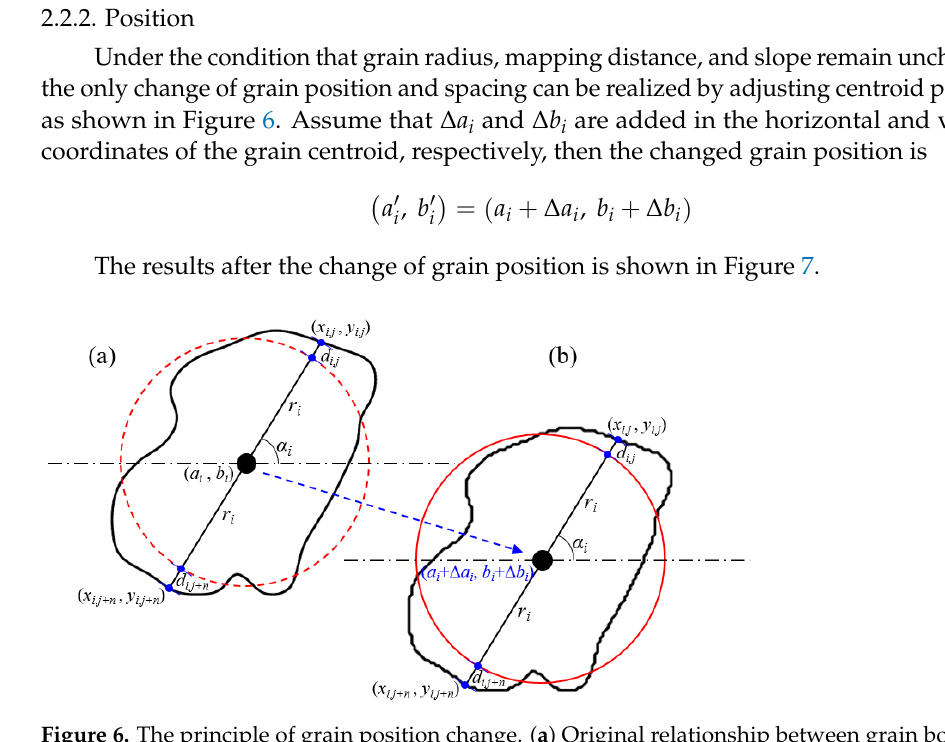
Figure 5. The results of grain size change.